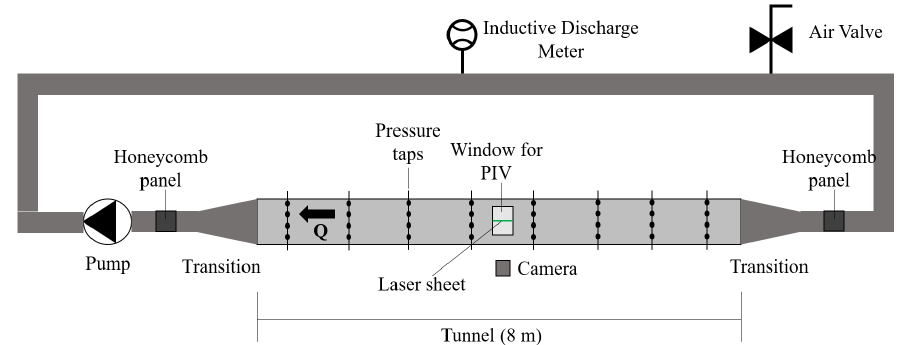
Figure 3. Setup-sketch of the physical model (not to scale), locations of the windows used for particle laser velocimetry (PIV)-measurements, and locations of the eight cross sections for pressure measurements.